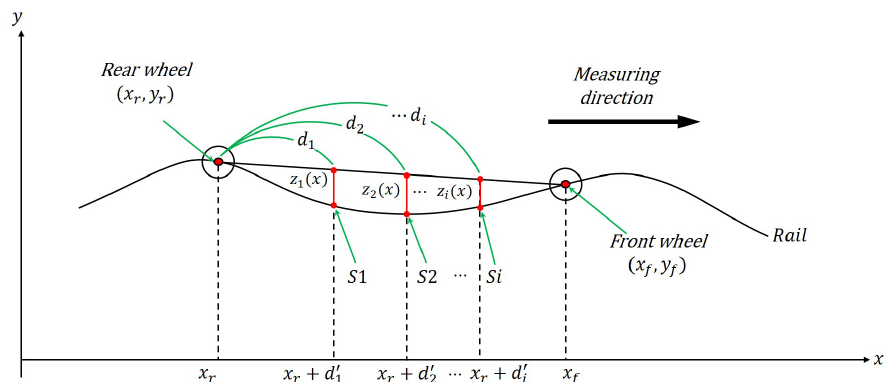
Figure 3. Multi-sensor-based chord offset synchronizing model ( α i = d i / L , and d i is the distance from x r to the i th sensor ( i = 1, 2, 3)) (Adapted and modified from